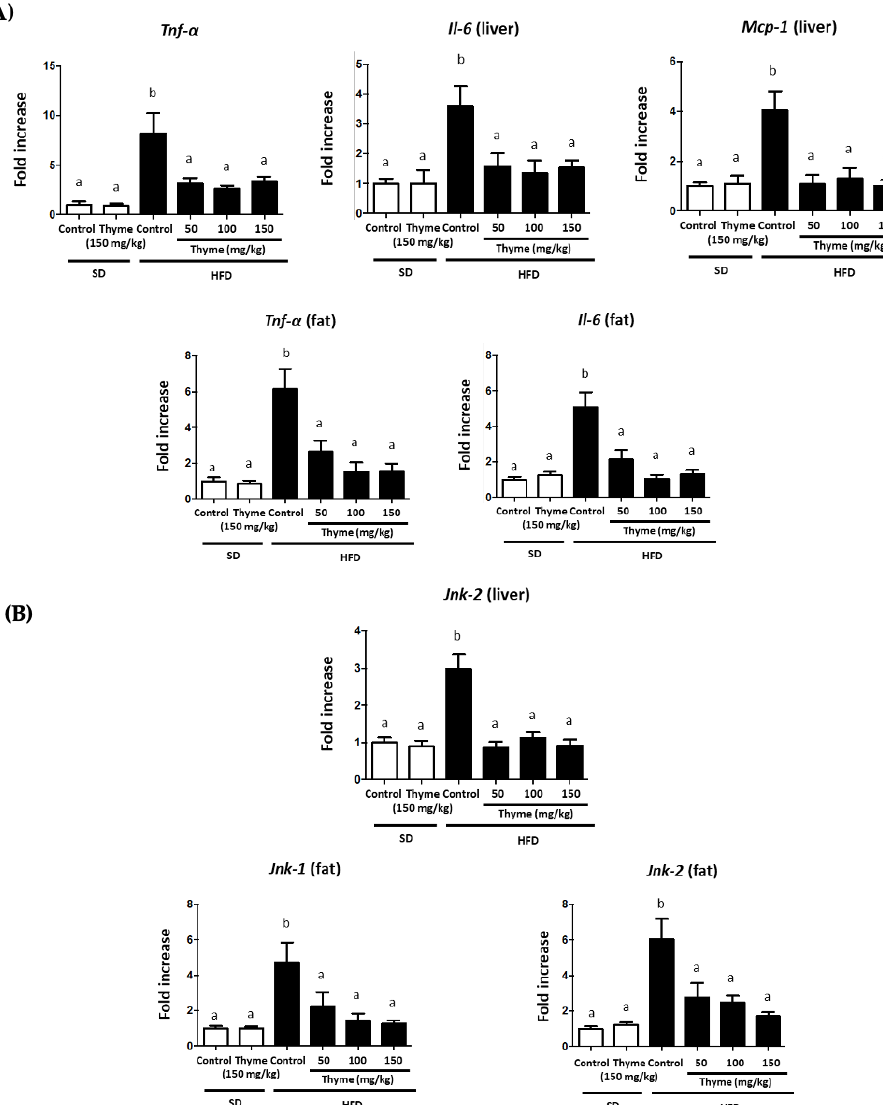
Figure 6. Effects of Thyme extract administration on: ( A ) gene expression of Tnf- α and Il-6 in liver and fat, as well as Mcp-1 in liver ( B ) and Jnk-1 and Jnk-2 in liver and fat. Data are expressed as means ± SEM ( n = 10). Groups with different letters statistically differ ( p < 0.05).